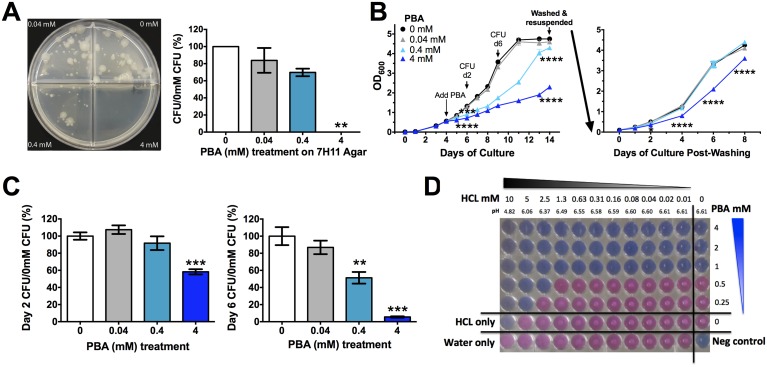
PBA inhihibts Mtb H37Rv growth on solid and in liquid medium.(A) Mtb 21 day growth on solid medium a 10-fold serial dilutin of PBA. (B) Growth of Mtb in rolling broth culutre as monitored by OD600 after addition of PBA on day 4 to a final concentration of 0.4-4mM PBA. 10-day treated culutres were washed and resuspended in PBA-free medium with growth monitored for a further 8 days. (C) Mtb growth in broth (B), assessed by CFU. (D) Checkerboard Alamar Blue reduction assay measuring MIC99 of PBA in the presence of 2-fold serial dilution of HCl, with pH of medium indicated. Growth occurs in pink wells with visible white Mtb pellets. Mean ± SEM, for dupicate experimetns, CFU plated in triplicate from growth curves, growth curves and Alamar Blue respresentative of replicate experiments, anlaysed by 1-way ANOVA, with Bonferroni multiple comparison test (A,C), or 2-way ANOVA, with Dunnett's multiple comparison test (B); *, P<0.05; **, P<0.01; ***, P<0.001, ****, P<0.0001.